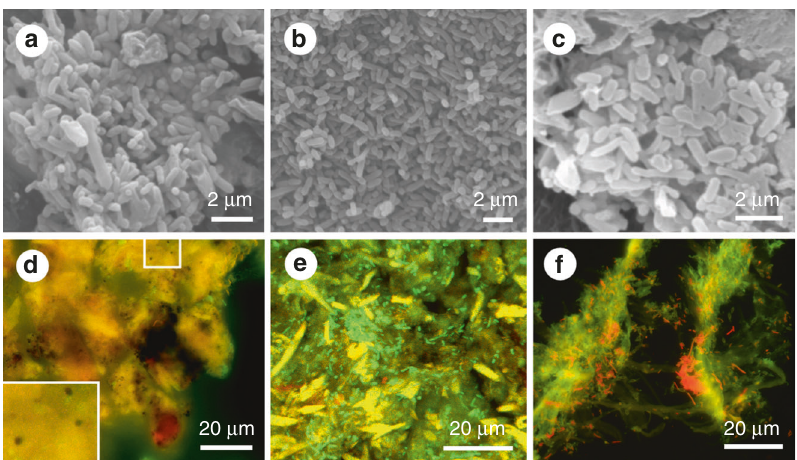
Fig. 2 Decayed tissues of extant frogs. a – c Scanning electron micrographs of rod-shaped decay bacteria within internal tissues of the torso in Kaloula ( a ), Xenopus ( b ) and Osteopilus ( c ). d – f Fluorescent micrographs of melanosomes ( d ) and rod-shaped bacteria ( e ) in the torso, and of rod-shaped bacteria in the thigh ( f ). Melanosomes appear black in fl uorescent images. Bacteria appear green and red. Scale bars, 2 μ m ( a – c ), 20 μ m ( d – f